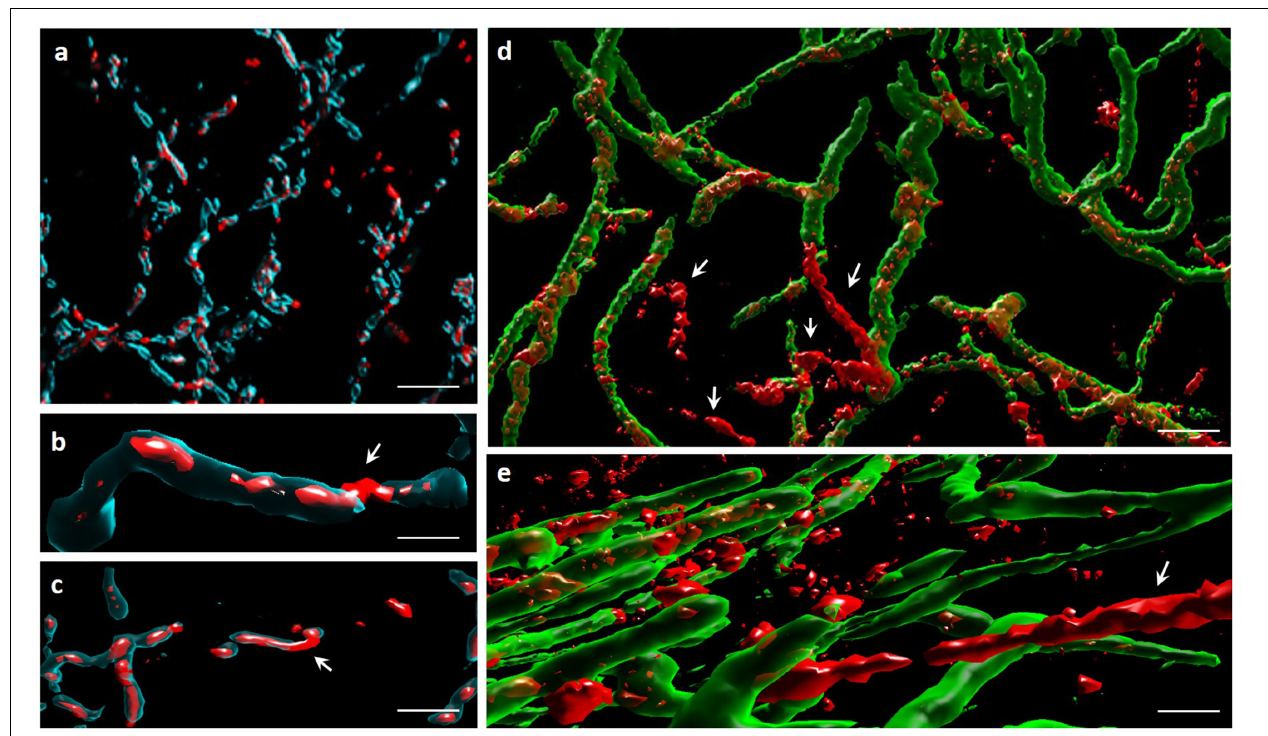
FIGURE 4 | Monitoring of PdG production at the filament size scale in S. coelicolor . (a–c) Filaments of S. coelicolor M145 inoculated on R2YE plates displaying both RAF and SYTOX (blue) staining. White arrows point to portion of filaments not stained with SYTOX and with abundant PdG production visualized by RAF. Bars, 10 µ m (a) , 2 µ m (b) , and 5 µ m (c) . (d,e) Filaments of S. coelicolor M145 inoculated on R2YE plates displaying both RAF and SYTO9 (green) staining. White arrows point to ‘ghost filaments’ with abundant production of PdGs and therefore not stained with SYTO9. Bars, 2 µ m (d) , and 1 µ m (e)